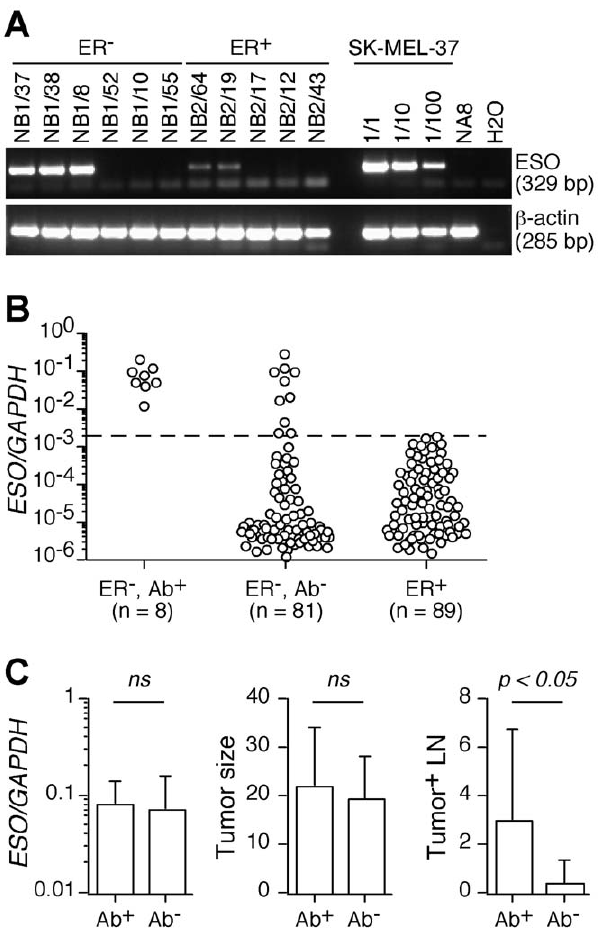
Figure 3. Assessment of ESO expression in ER 2 and ER + BC tumors. A and B . ESO expression in cryopreserved ER 2 and ER + BC tumors was assessed by semi-quantitative PCR ( A ) and qPCR ( B ). C . The level of ESO expression in the tumor as assessed by qPCR (left panel, mean 6 SD), the size of the primary tumor at diagnosis (middle panel, mean 6 SD) and the number of tumor-invaded lymph nodes (right panel, mean 6 SD) are shown for ESO Ab + (n=8) and ESO Ab 2 (n=10) patients with ESO-expressing tumors. Statistical analyses were per- formed using a two-tailed t-test.